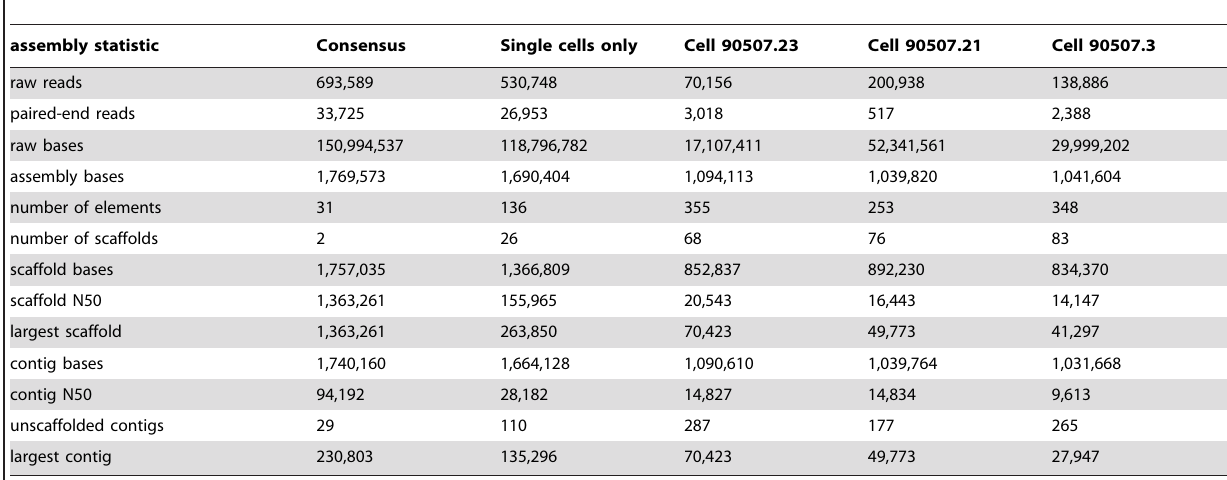
Table 1. N. limnia assembly statistics for the consensus genome (metagenome and five single cells), single cell coassembly (five single cells), and three individual cell